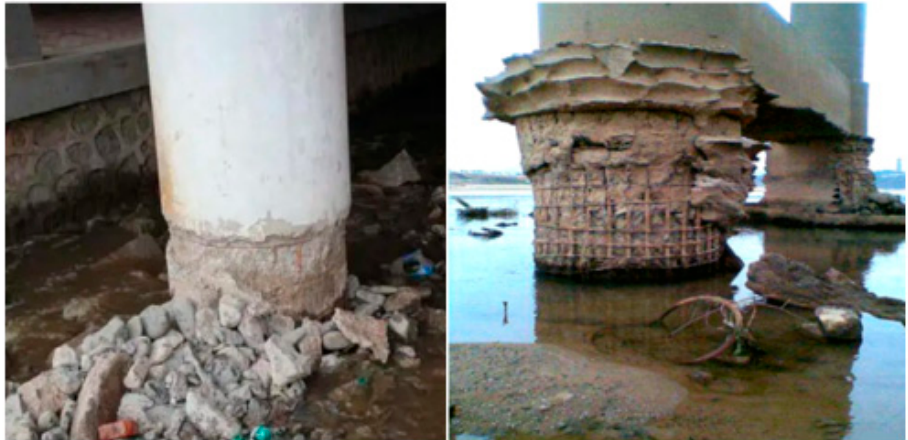
Figure 1. Damage modes of RC columns due to the combined action of freeze–thaw cycles and chloride-induced corrosion.